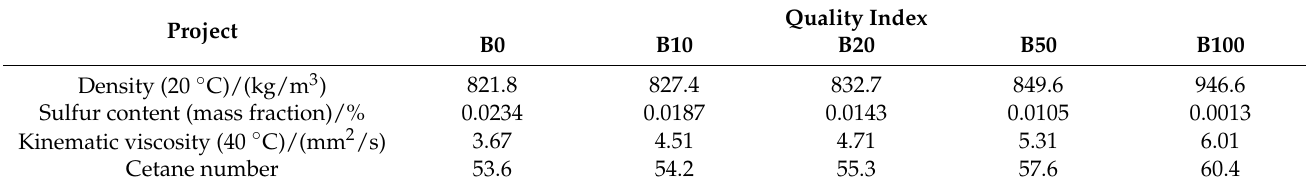
Table 6. Comparison of physical and chemical characteristics of diesel and